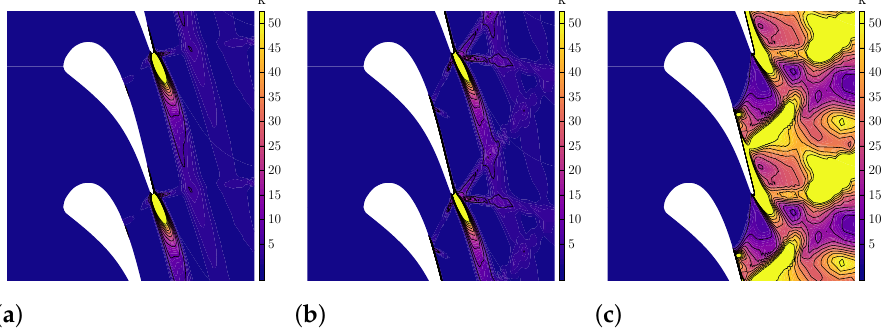
Figure 11. Isocontours of turbulent kinetic energy k for cases IC1-LPR ( a ), IC1-HPR ( b ), and IC2- LPR ( c